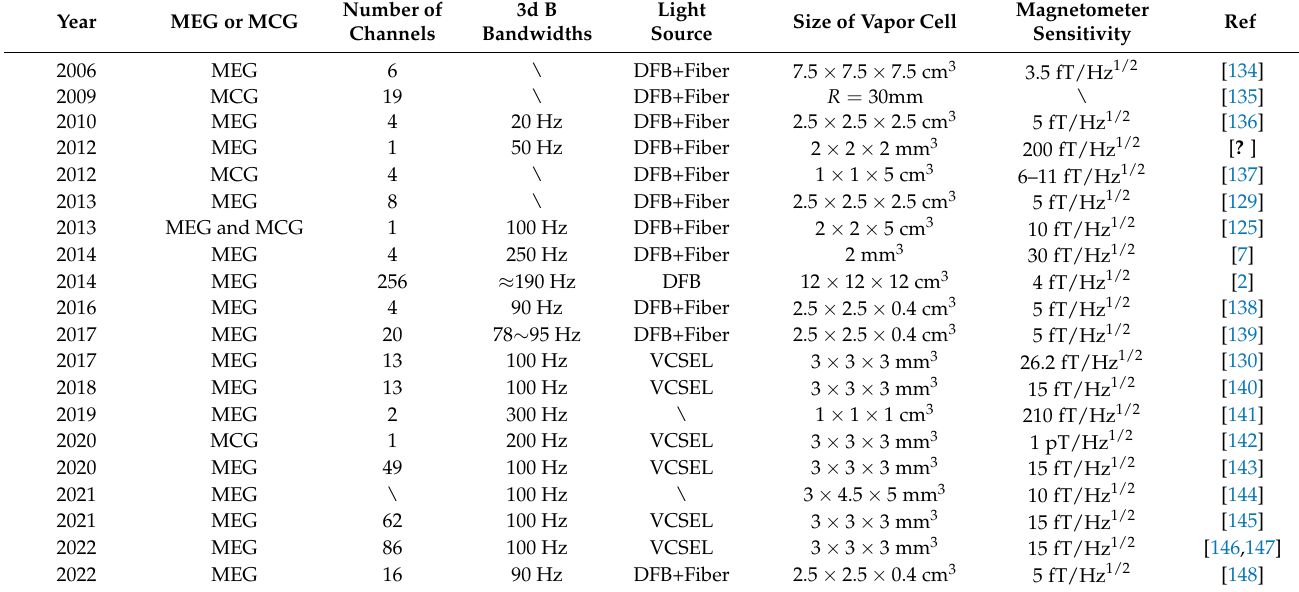
Table 4. Research progress of an optically pumped magnetometer in the field of MCG and